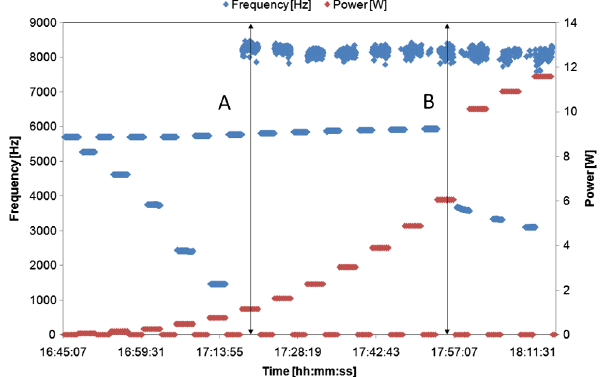
FIG. 8. Frequency change during target wire heating by a dc current. Blue dots: vibrating wire frequency; red dots: power dissipated into the target wire. After the power level of 1.15 W (indicated by line A), unstable parasitic frequencies ( ∼ 8000 Hz) appeared. When the current was switched off, stable oscillation of the vibrating wire was recovered. These processes continued until the power deposition reached 6.04 W (indicated by line B);